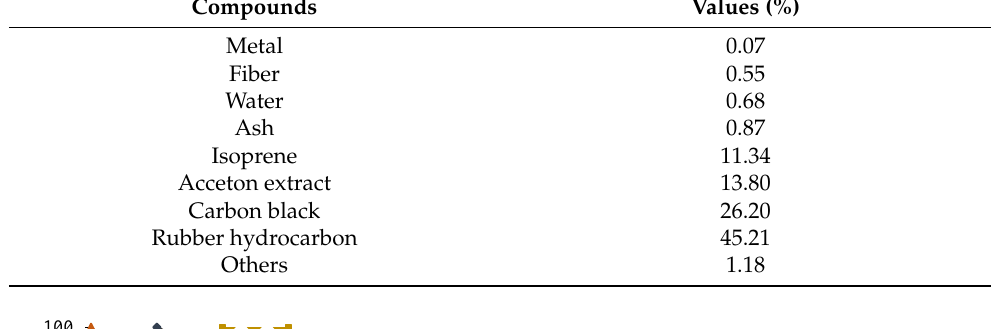
Figure 2. Rubber waste: ( a ) R1, ( b ) R5, ( c ) R10.